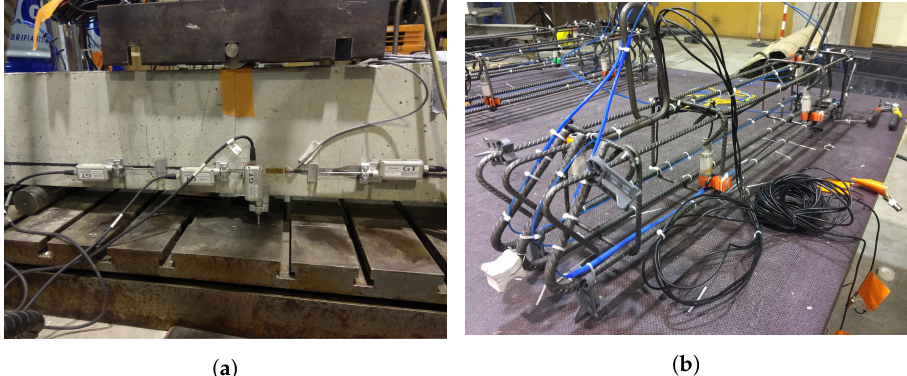
Figure 3. ( a ) front view of the loading arrangement and the beam instrumented with sensors before testing; ( b ) Ultra Sonics (US) and Distributed Fiber optics (DFO) sensors attached to the rebars before casting of